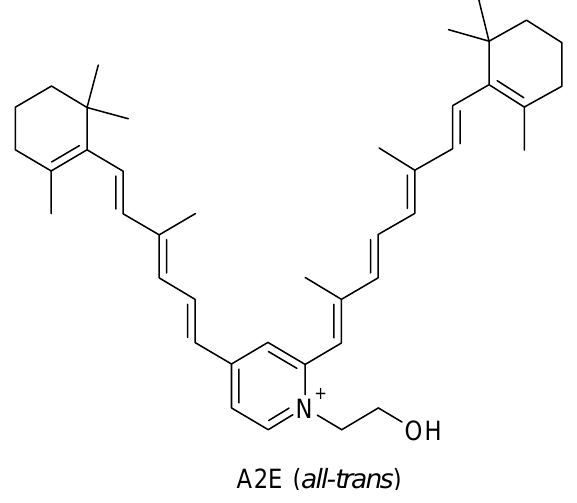
Figure 11: A2E, a fluorescent retinoid derivative isolated from retinal pigment epithelial